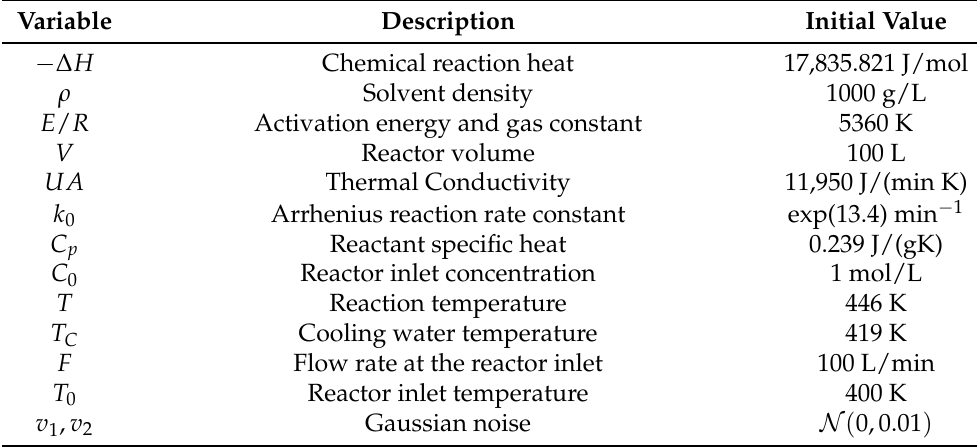
Table 2. CSTR process variable description and its initial value.